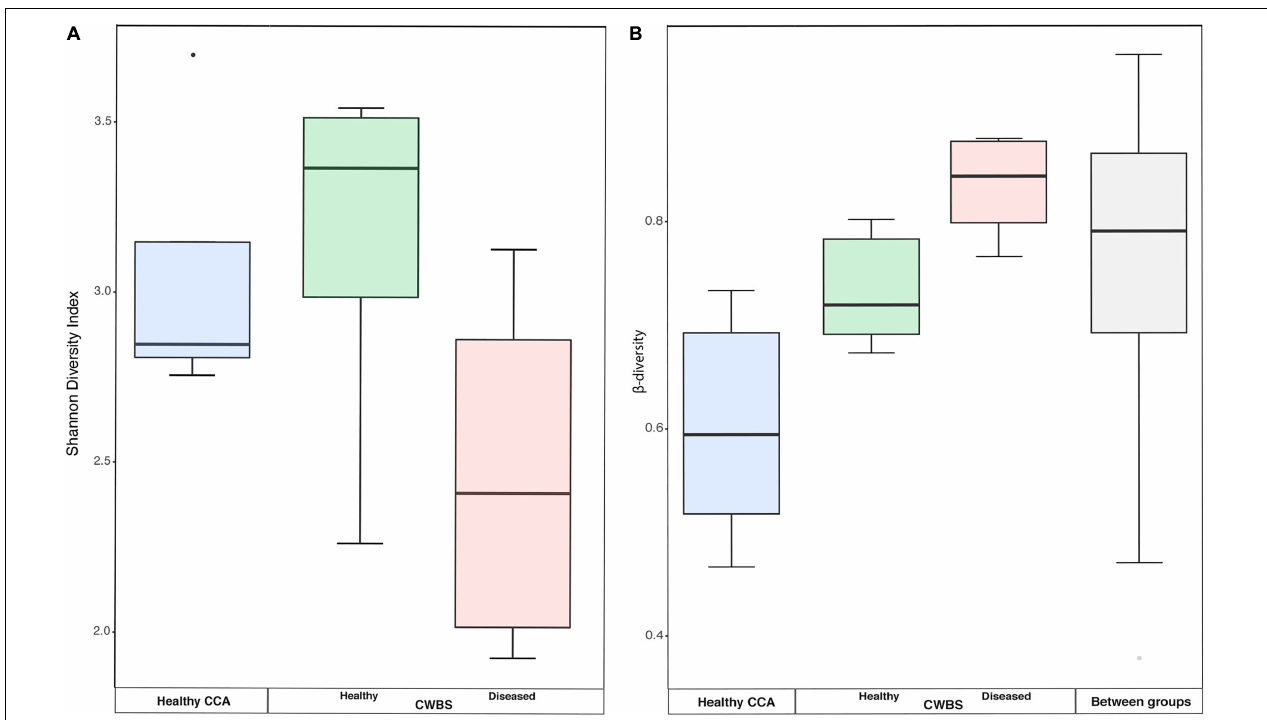
FIGURE 3 | (A) Boxplot showing the diversity (Shannon index) based on 16S rRNA sequences from healthy and diseased CCA tissues. (B) Boxplots showing the beta-diversity expressed as the Bray–Curtis distance within all samples of each health group, as well as between health groups. The box represents the inter-quartile range between the upper and lower quartile. The median value is represented by the horizontal line and minimum and maximum values are represented by whiskers.